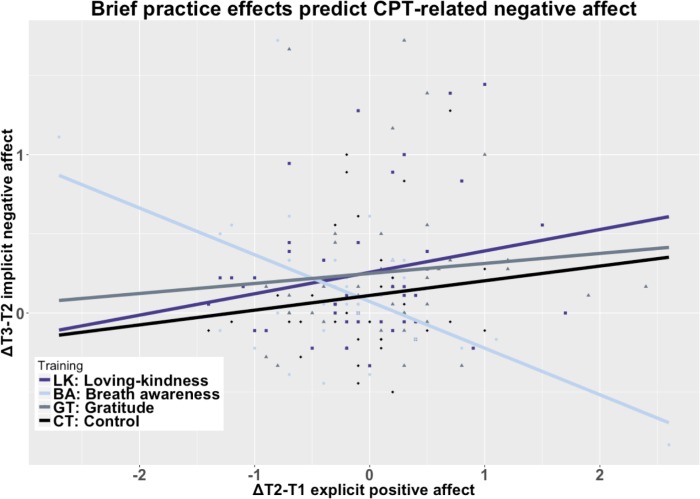
Positive affect training gains x GROUP predict post-CPT face likability ratings.Notes: Implicit positive affect following practice in GT predicts stressor-induced decreases in face likability ratings whereas in LK, BA, and CT practice-related implicit positive affect gains predict higher likability ratings GT-LK t(76) = -2.68, p = .020, d = -0.40 CI[0.1, 0.70], GT-BA t(68) = -2.51, p = .020, d = -0.39 CI[-0.71, -0.07], and GT-CT t(73) = -2.12, p = .036, d = -0.33 [-0.65, -0.01] (corrected).